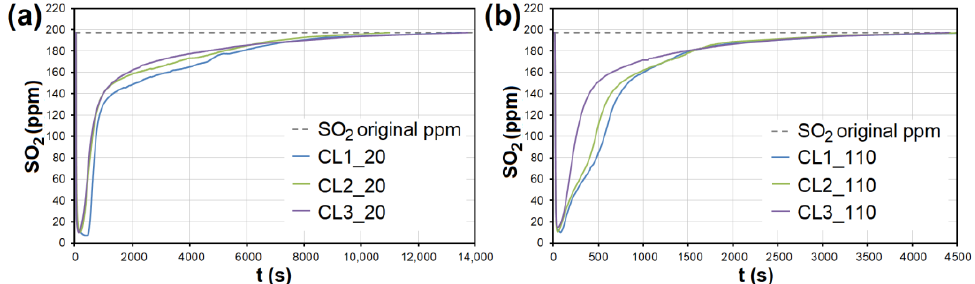
Figure 10. The adsorption curves showing SO 2 adsorption on CL at adsorbent temperatures of ( a ) 20 °C and ( b ) 110 °C. CL1-3 — clay at different granulometric fractions (see Table 1).